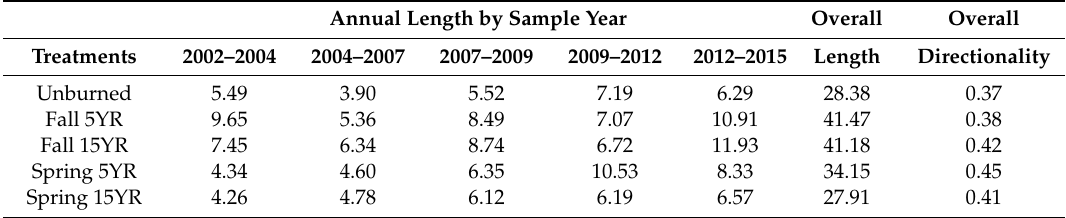
Table 3. Treatment-level annual trajectory length, overall trajectory lengths, and overall directionality.